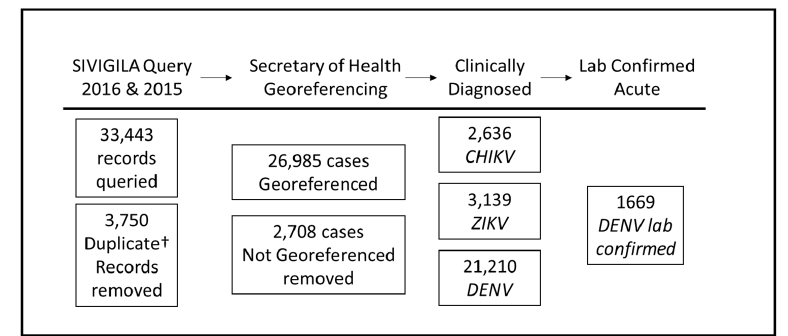
Figure A1. We officially requested the Municipal Secretary of Health to provide cases matching event codes 210 (DENV), 220 (severe DENV), 580 (DENV death), and 217 (CHIKV) for 2014 to 2015. We repeated the query in 2016 to request updated data including event code 895 (ZIKV). † Duplicates defined as same identification number, week of identification, and disease code. Table A1. DENV lab results by assay and antigen.